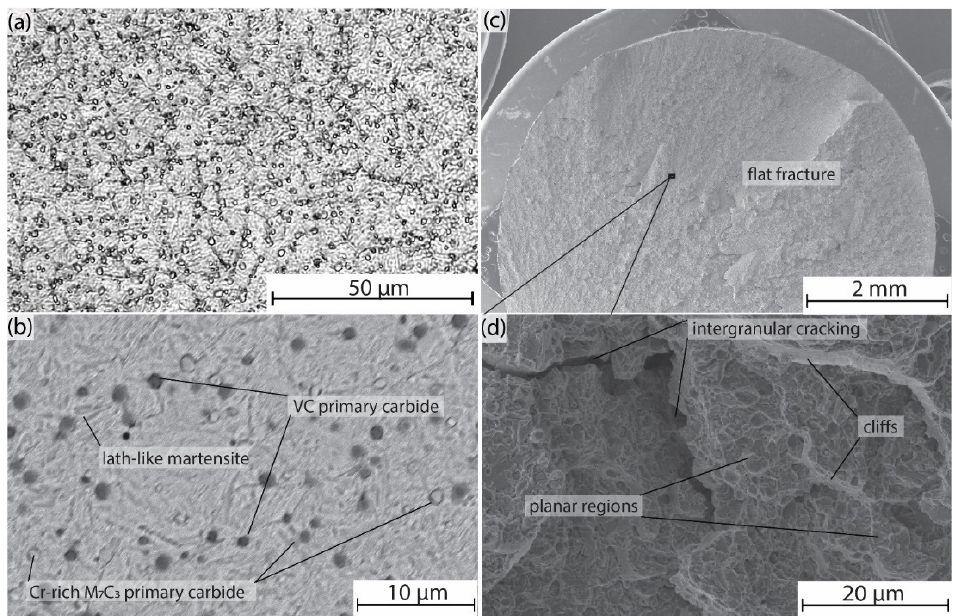
Figure 4. ( a ) Reflected light image of As-Hardened sample. Bright regions in the lath-like background are interpreted to be retained austenite. ( b ) Backscatter electron image highlighting the lath-like as-quenched martensite and mixed primary carbides. ( c ) Wide-field secondary electron image of fracture surface highlighting the flat brittle fracture mode. ( d ) Small-scale secondary electron image highlighting brittle features.